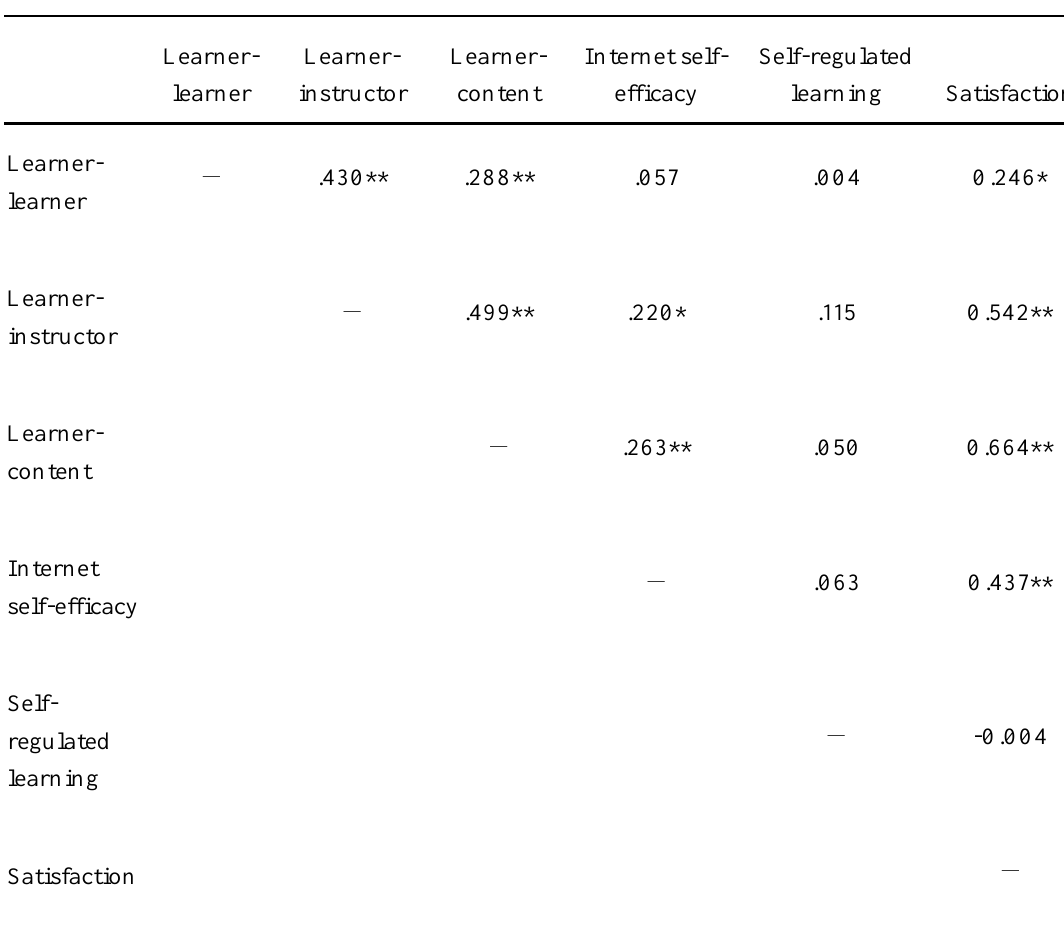
Correlations between